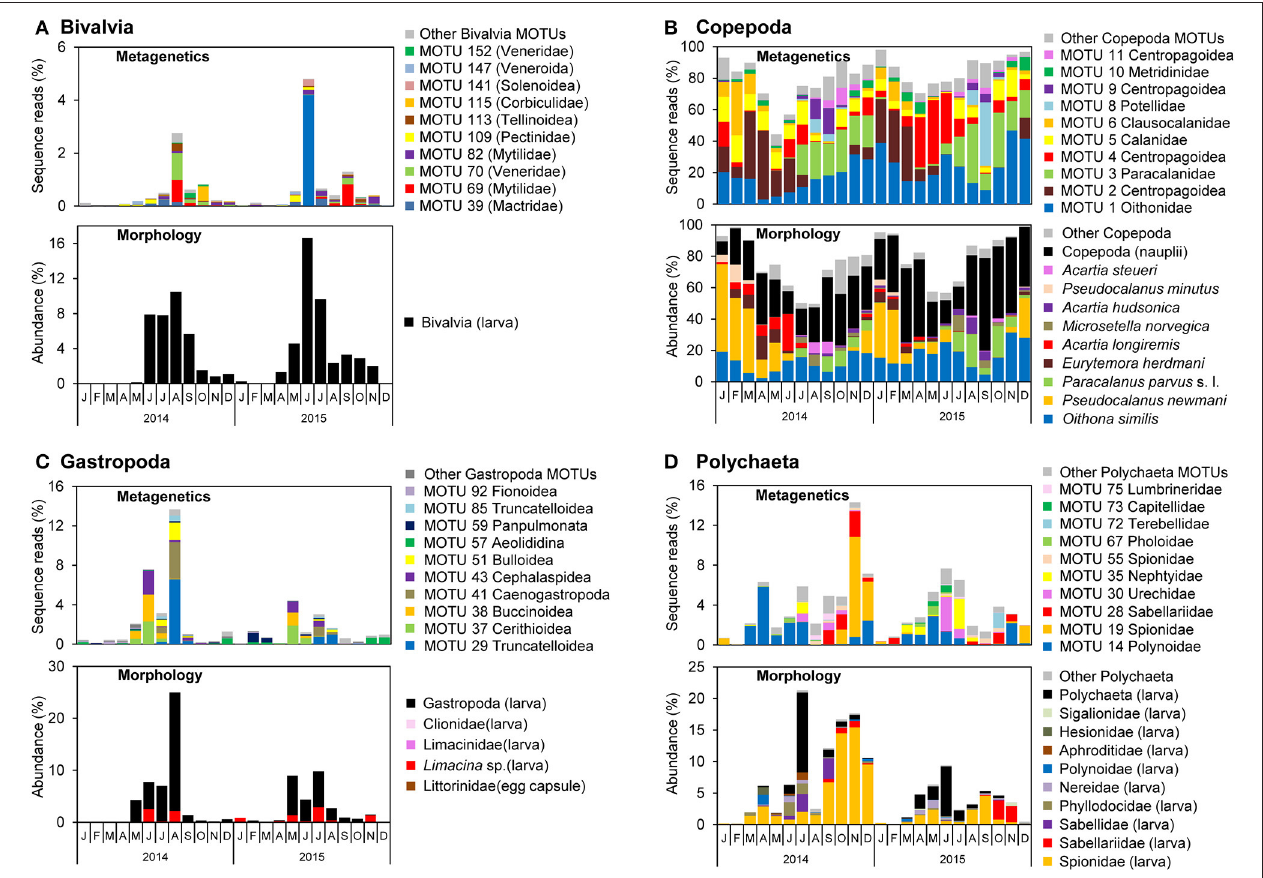
FIGURE 7 | Monthly proportions of sequence reads for major molecular taxonomic units (MOTUs) using metagenetic analysis and abundance using morphological analysis in (A) Bivalvia, (B) Copepoda, (C) Gastropoda, and (D) Polychaeta. Proportions of sequence reads or abundances are calculated per sample and averaged per